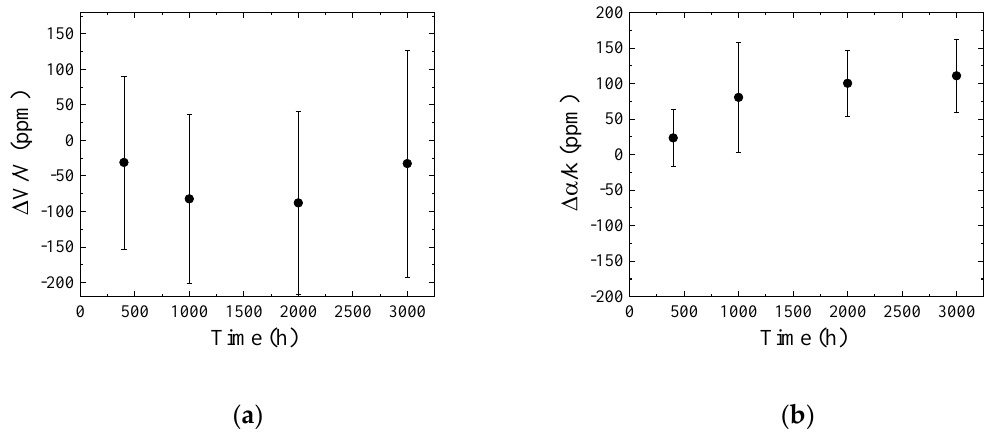
Figure 9. ( a ) Velocity and ( b ) attenuation changes obtained from Ch.1 as a function of heated time.